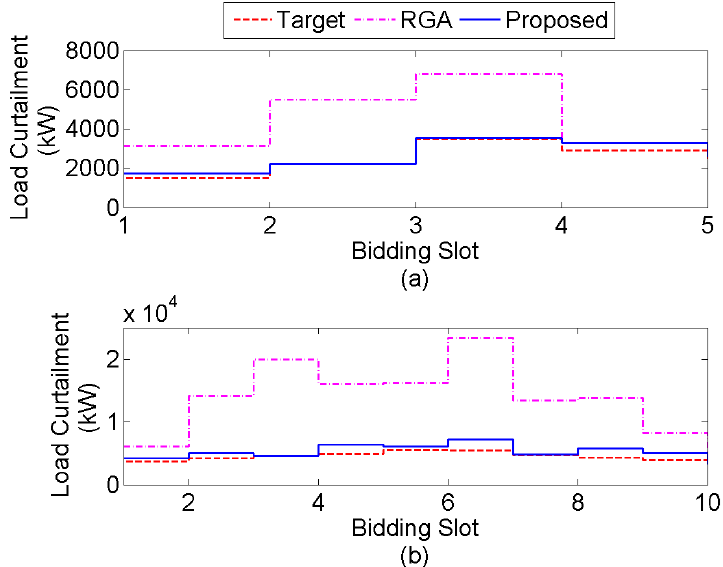
Figure 5. The actual load curtailment profiles produced by both compared methods with respect to the target profile in ( a ) case 1 and ( b ) case 2 of demand bidding. Table 3. Comparison of the average load difference produced by all compared